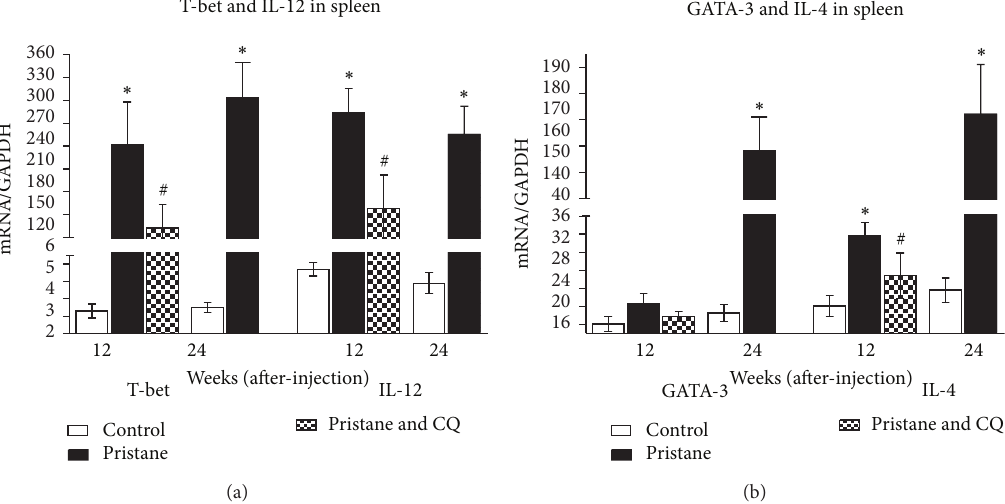
Figure 5: Effects of pristane alone or in combination with chloroquine on Th1/Th2 associated gene expression by RT-PCR analysis. Relative mRNA expression was normalized to GAPDH. CQ: chloroquine. Bars represent mean ± SE of three replicate experiments, ∗ 𝑃 < 0.05 versus the corresponding control mice, # 𝑃 < 0.05 versus mice exposure to pristane for 12